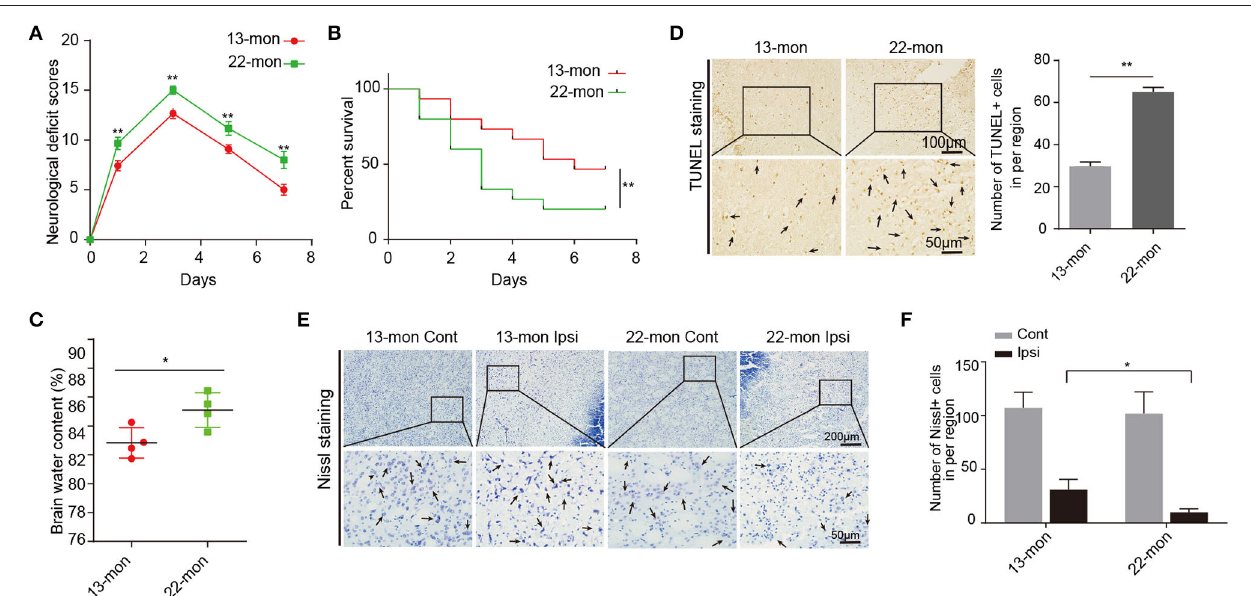
FIGURE 1 | Acute brain injury and mortality induced by ICH in rats. (A) The neurological deficit scores of 13- and 22-month-old ICH rats ( n = 12). (B) The survival rates of 13- and 22-month-old ICH rats ( n = 15). (C) Level of brain water contents in perihematomal brain tissues in 13- and 22-month-old rats 3 days after ICH surgery ( n = 4). (D) TUNEL assay and quantification of apoptotic neural cells in perihematomal brain tissues derived from 13- and 22-month-old rats 3 days after ICH surgery. Scale bars, 100 µ m at the top and 50 µ m at the bottom. (E,F) Nissl staining and quantification of Nissl bodies in perihematomal brain tissues derived from 13- and 22-month-old rats 3 days after ICH surgery. Scale bars, 200 µ m at the top and 50 µ m at the bottom. The bar graphs show the mean ± SEM. p -value was determined by using the Student’s t -test. * p < 0.05 and ** p < 0.01,